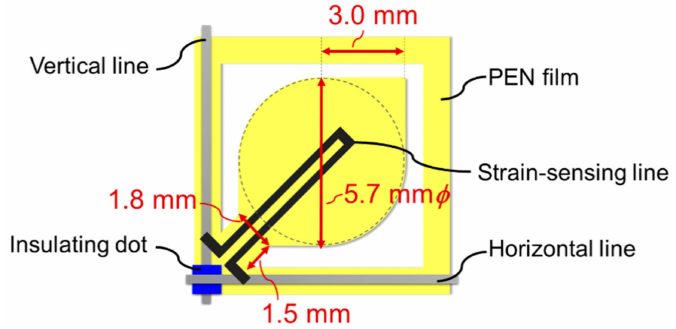
Figure 2. Single-element design of the wind pressure distribution